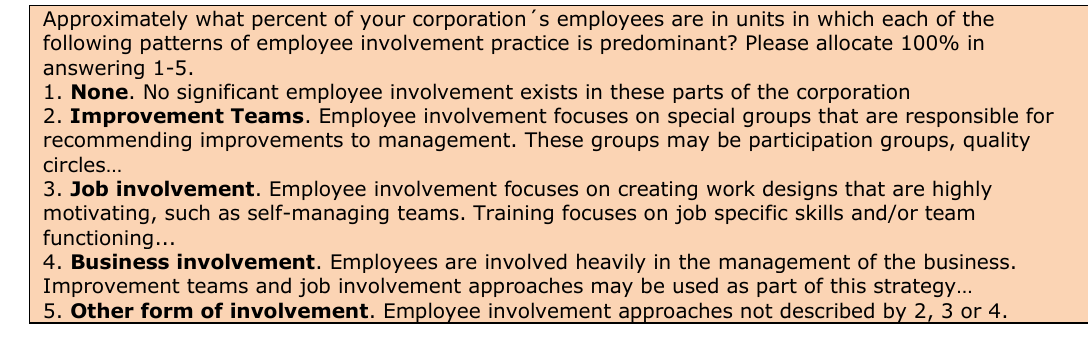
Table 5. Question samples from type C questionnaires (Lawler III et al., 1998)